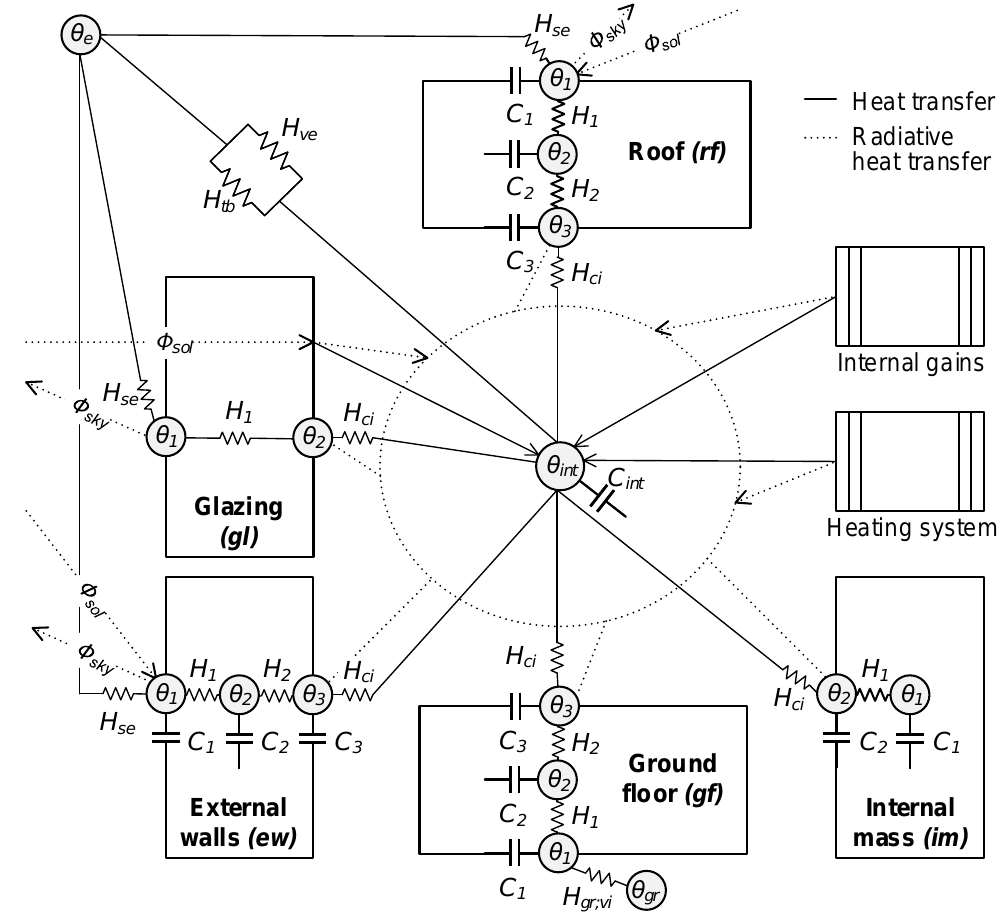
Figure 2. An RC network representation of the proposed ISO14N